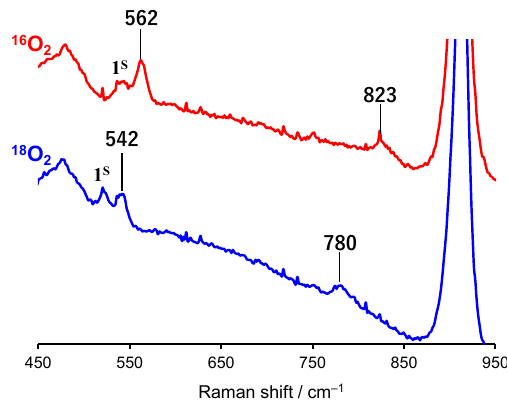
Figure 2. Resonance Raman spectra of 1 H derived from 16 O 2 (red) and 18 O 2 (blue). The Co-O stretch- ing bands attributed to the remaining superoxido complex 1 S were observed.